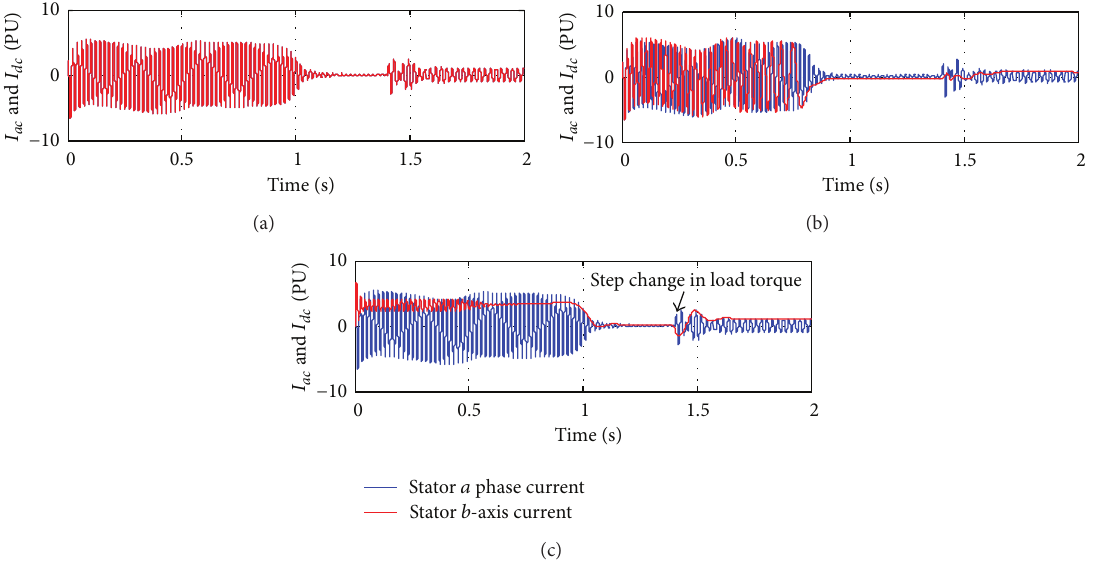
Figure 3: Simulated results of “ 𝑎 ” phase and 𝑑 -axis stator currents in different rotating reference frames.